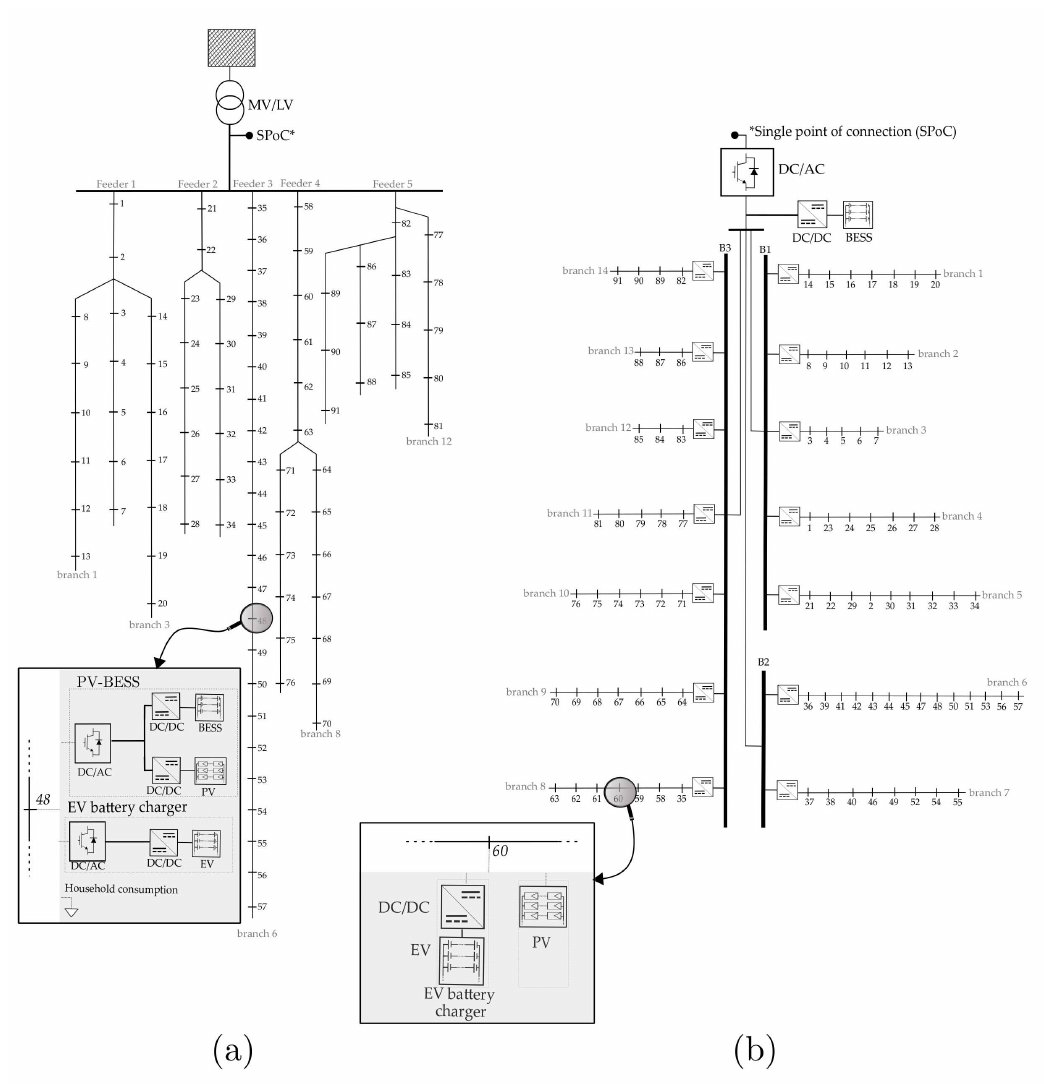
Figure 1. Line diagram of the studied LV DN with a detailed view of the connection of the load and SDGEs, with ( a ) the conventional approach and ( b ) the proposed LVDC